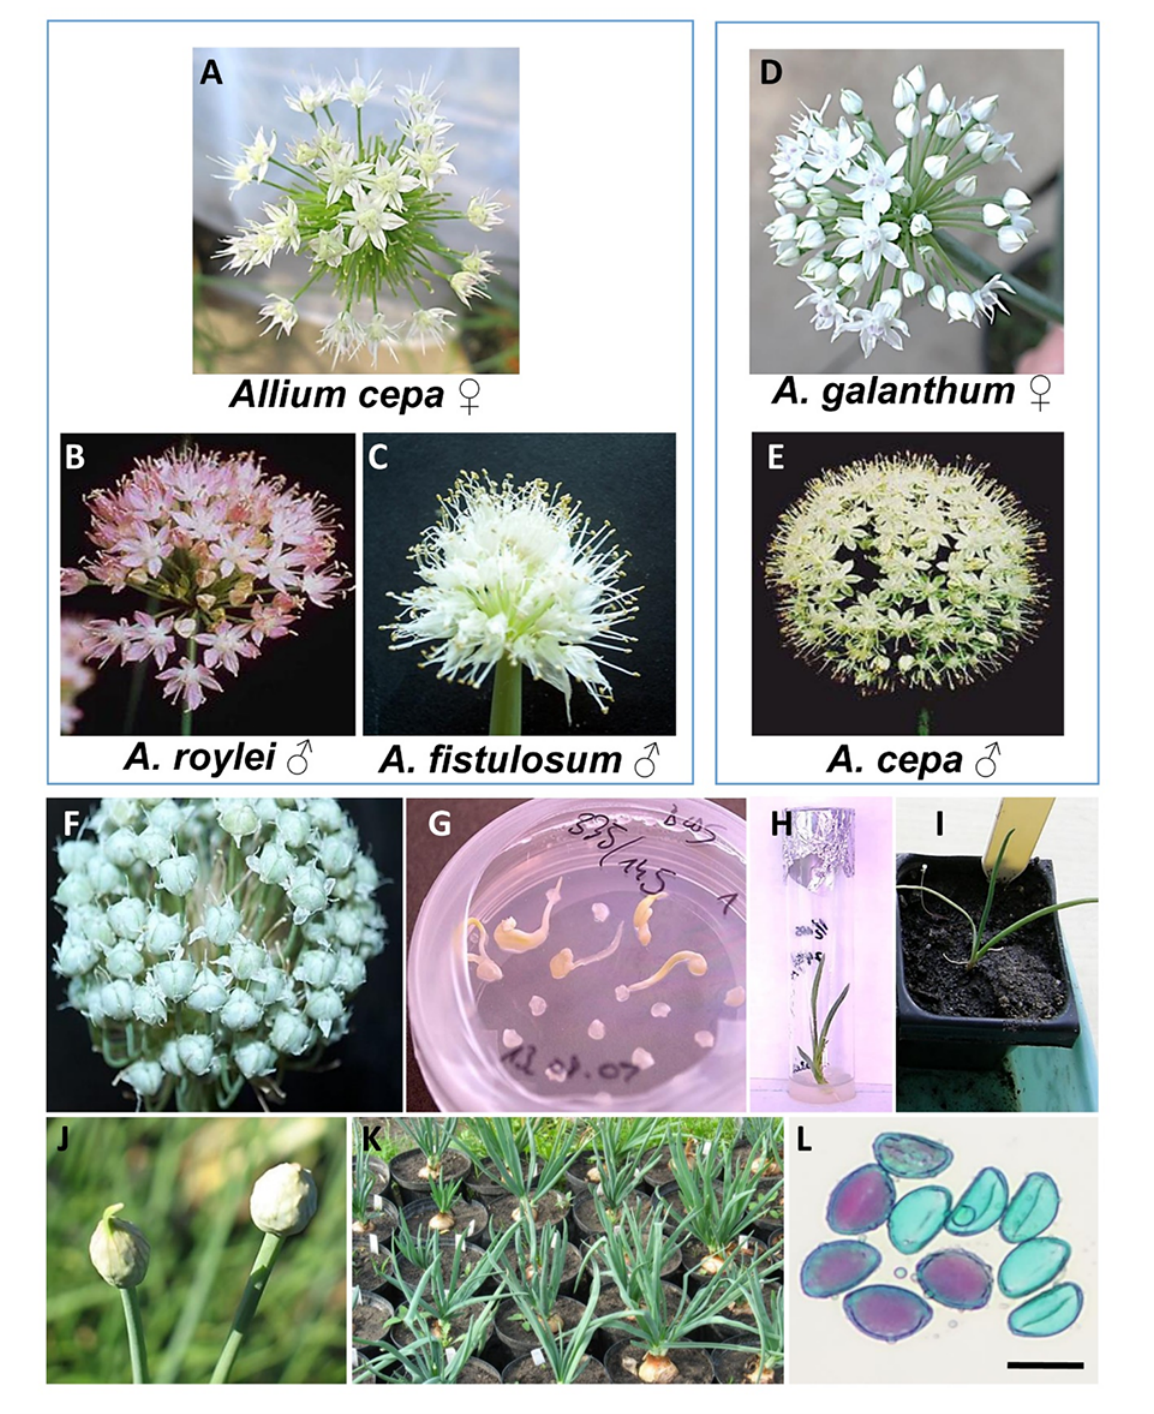
Figure 3 Obtaining interspecific F hybrids in Allium through in vitro culture. Allium cepa : An emasculated umbel ( A ) and an 1 umbel serving as the pollen donor ( E ). Pollen donors: Allium roylei ( B ), Allium fistulosum ( C ). Emasculated umbel of Allium galanthum ( D ). Enlarged ovaries at 10 days aer pollination of Allium cepa with the pollen of Allium roylei ( F ). Embryo rescue: Excised ovules and embryo development aer crossing of Allium cepa and Allium roylei ( G ). Regenerated F roylei ) plantlet ( H ). F ( Allium galanthum × Allium cepa ) regenerant acclimatized to ex vitro conditions ( I ). Flowering of F 1 cepa × Allium roylei ) hybrids ( J ). F hybrids ( Allium galanthum × Allium cepa ) planted into pots ( K ). Pollen viability of F 1 ( Allium galanthum × Allium cepa ) hybrid tested with Alexander’s dye: Partially viable ( L ) pollen; magenta-green pollens are viable, transparent-green pollens are sterile. Scale bar: 20 μm. All photographs are retrieved from the archives of the Department of Plant Biology and Biotechnology, Faculty of Biotechnology and Horticulture, University of Agriculture in